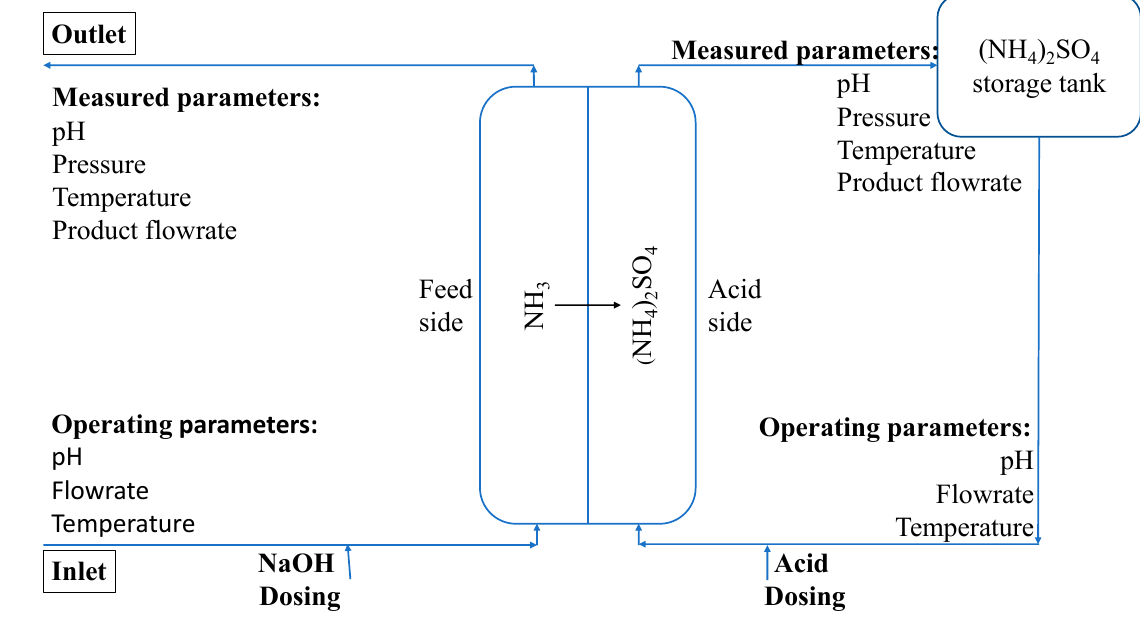
Figure 9. Simplified schematic of process overview (not to scale).